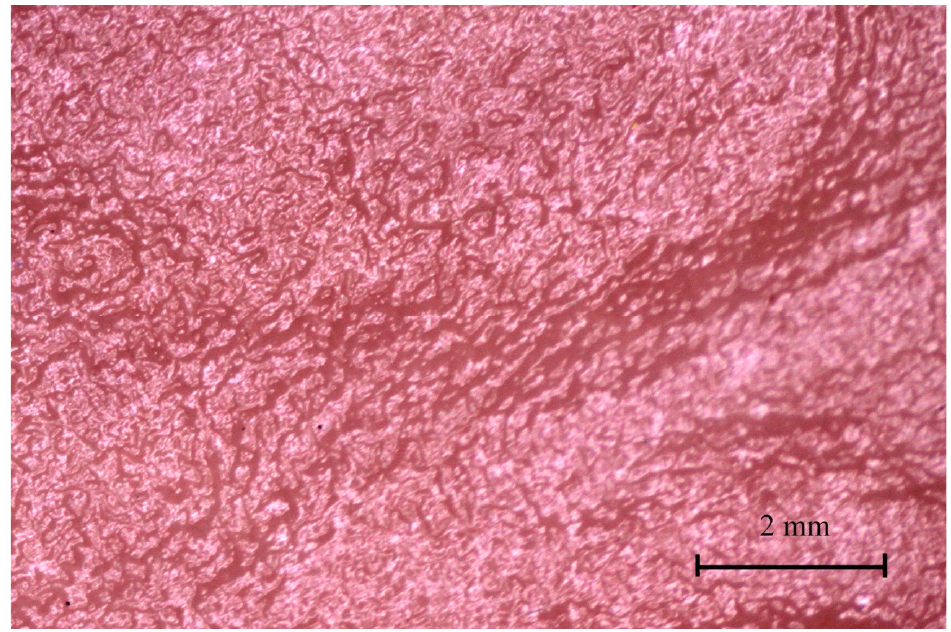
Figure 15. Gastric mucosa of the stomach body (third age group).